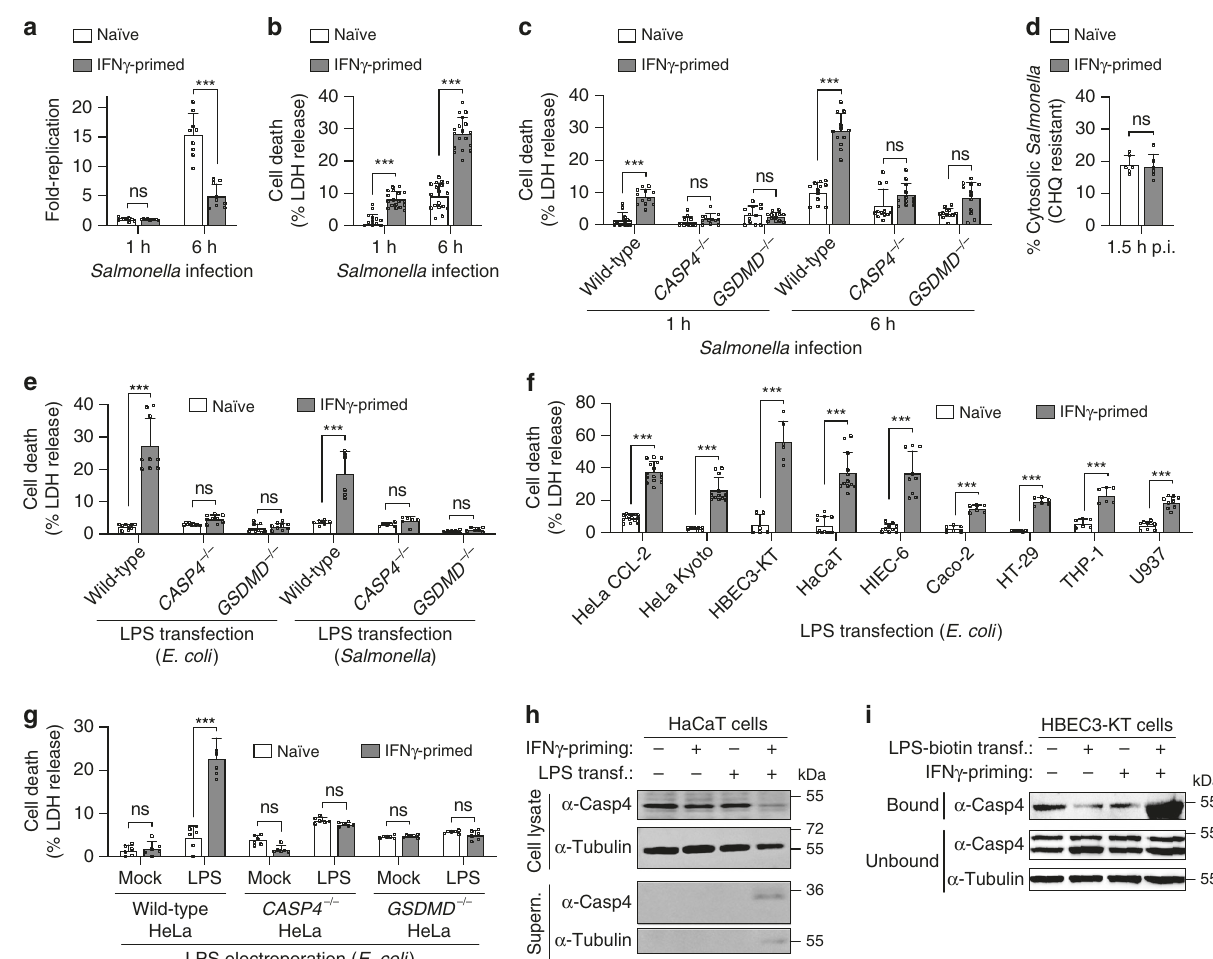
Fig. 1 IFN γ priming is required for LPS-induced caspase-4 activation in human epithelial cells. a – c Intracellular bacterial fold-replication ( a ) and release of LDH ( b , c ) in naive or IFN γ -primed wild-type, CASP4 – / – or GSDMD – / – HeLa cells, at 1 or 6-h post-infection (p.i.) with Salmonella . Cells in 96-well plates were infected for 30 min, washed and gentamicin was added to kill extracellular bacteria. At the indicated time points supernatant was collected to determine the release of LDH, and then cells were lysed and the number of viable intracellular bacteria was determined by counting colony forming units (CFUs). The bacterial fold-replication was calculated relative to 1 h p.i. d Percentage of CHQ-resistant cytosolic Salmonella in naive or IFN γ -primed HeLa at 1.5 h p.i. Cells were infected for 30 min as in ( a ) and then treated with gentamicin ± CHQ for an additional 1 h before cells were lysed and bacteria counted by CFUs. The percentage of cytosolic bacteria was calculated as the ratio of (CHQ + gentamicin resistant / gentamicin resistant ). e – g Release of LDH from naive or IFN γ -primed cells, 5 h after transfection with LPS (2.5 µ g/50,000 cells) or 3 – 4 h after electroporation with LPS (300 ng/50,0000 cells). h Western blot analysis of full length (p43) and cleaved (p32) caspase-4 in the supernatants and cell lysates from naive or IFN γ -primed HaCaT cells, upon transfection with E. coli LPS LPS (2.5 µ g/50,000 cells). i Streptavidin pull-down assay of the binding of biotin-conjugated LPS to endogenous caspase-4 from the lysates of naive or IFN γ -primed HBEC3-KT. Cells in 6-well plates were transfected with LPS-biotin (10 µ g) or left untransfected, and biotinylated substrate was pulled down using equal amounts of streptavidin magnetic beads, which were then eluted in equal volumes of SDS-PAGE reducing sample buffer. Streptavidin-bound and -unbound fractions were analyzed by immunoblotting for caspase-4. Graphs show the mean ± SD, and data are pooled from two to six independent experiments performed in triplicate ( a – g ) or representative of two ( h , i ) independent experiments. *** P < 0.001; ns, not signi fi cant; two-tailed t (Supplementary Fig. 2f). In accordance, LPS transfection only induced caspase-4 and GSDMD cleavage in IFN γ -primed cells (Fig. 1h and Supplementary Fig. 2g). Importantly, IFN γ -priming had no impact on the level of caspase-4 expression, since unlike murine caspase-11, caspase-4 was not induced by IFN γ (Fig. 1h, i (Fig. 1g and Supplementary Fig. 2e) in a panel of human cell and Supplementary Fig. 2c, g, h). To assess if IFN γ controlled lines and primary cells, including human small intestinal epithelial cells (HIEC-6). To further substantiate that caspase-4 activation requires IFN γ , we transfected LPS into naive or IFN γ - primed cells and pulled down active caspase-4 using a cell- permeable pan-caspase activity probe, biotin-VAD(Ome)-fmk (bVAD-fmk) 26 . Active caspase-4 was only pulled down when cells where fi rst primed with IFN γ and then transfected with LPS